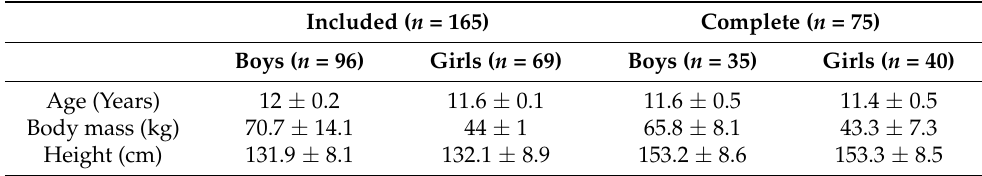
Table 1. Sample characterization (baseline).